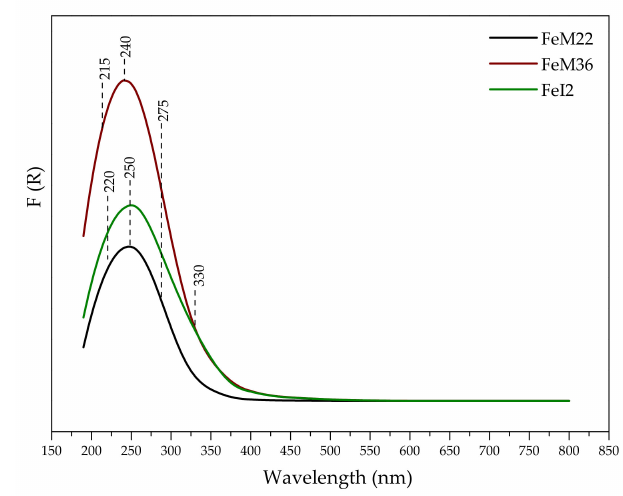
Figure 5. UV-Vis spectra obtained for Fe-MWW layered zeolites.